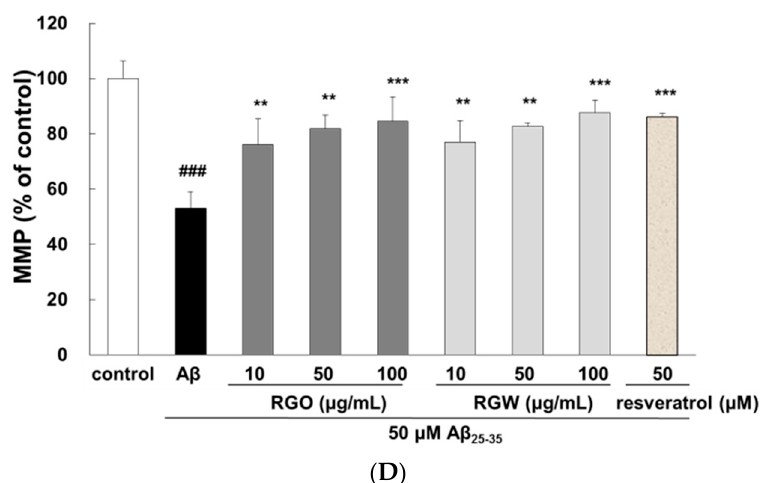
Figure 3. Effect of RGO and RGW on cell cycle and mitochondrial membrane potential (MMP). Flow cytometry of cell cycle phase ( A ) and quantification ( B ). Representative flow cytometry of Rhodamine 123 staining for MMP (×400) ( C ). Statistical analysis results of the percentage of MMP through Rhodamine 123 intensity ( D ). The graph shows the cell cycle and MMP as described in Materials and Methods. ### p < 0.001 and ## p < 0.01 compared to control group; *** p < 0.001, ** p < 0.01 and * p < 0.05 compared to A β 25–35 alone (ANOVA followed by Duncan’s multiple comparison test). Resveratrol was used as a positive control.